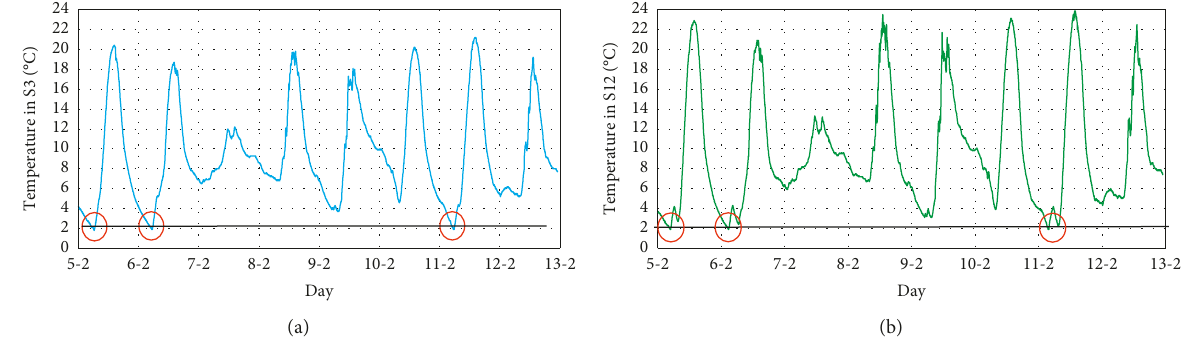
Figure 8: Surface temperatures recorded by sensors in (a) S3 and (b) S12.